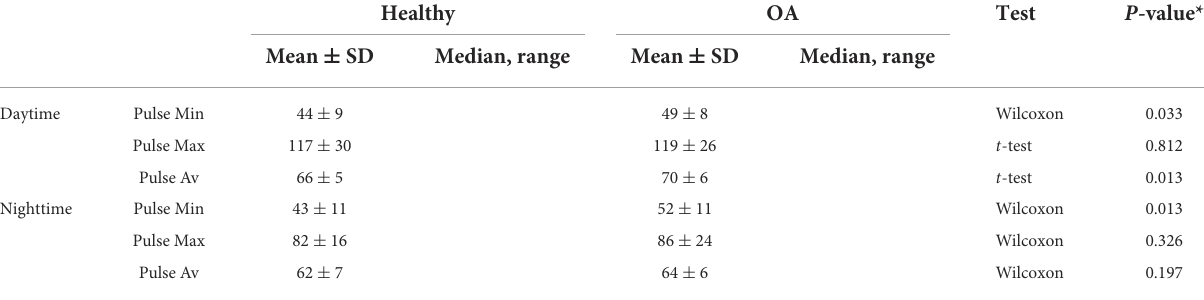
TABLE 7 Pulse measured by the PetPace device.